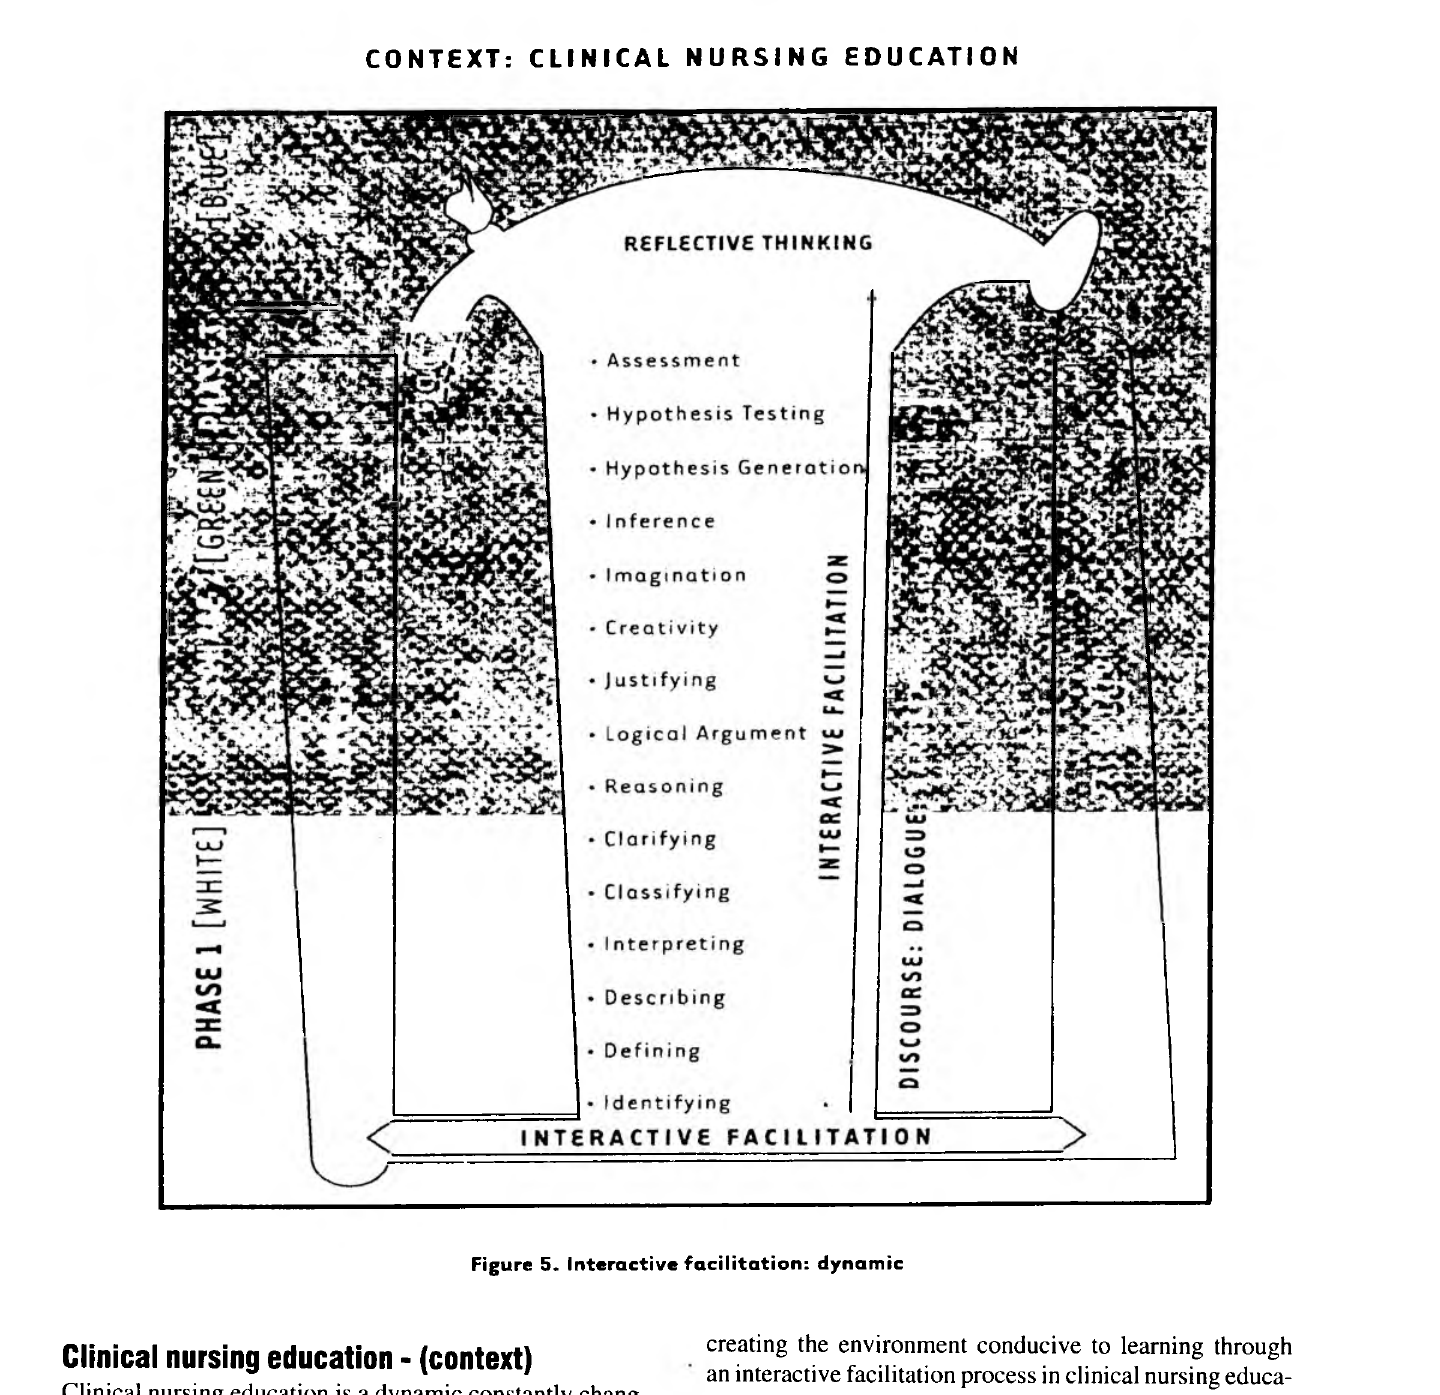
Figure 5. Interactive facilitation: